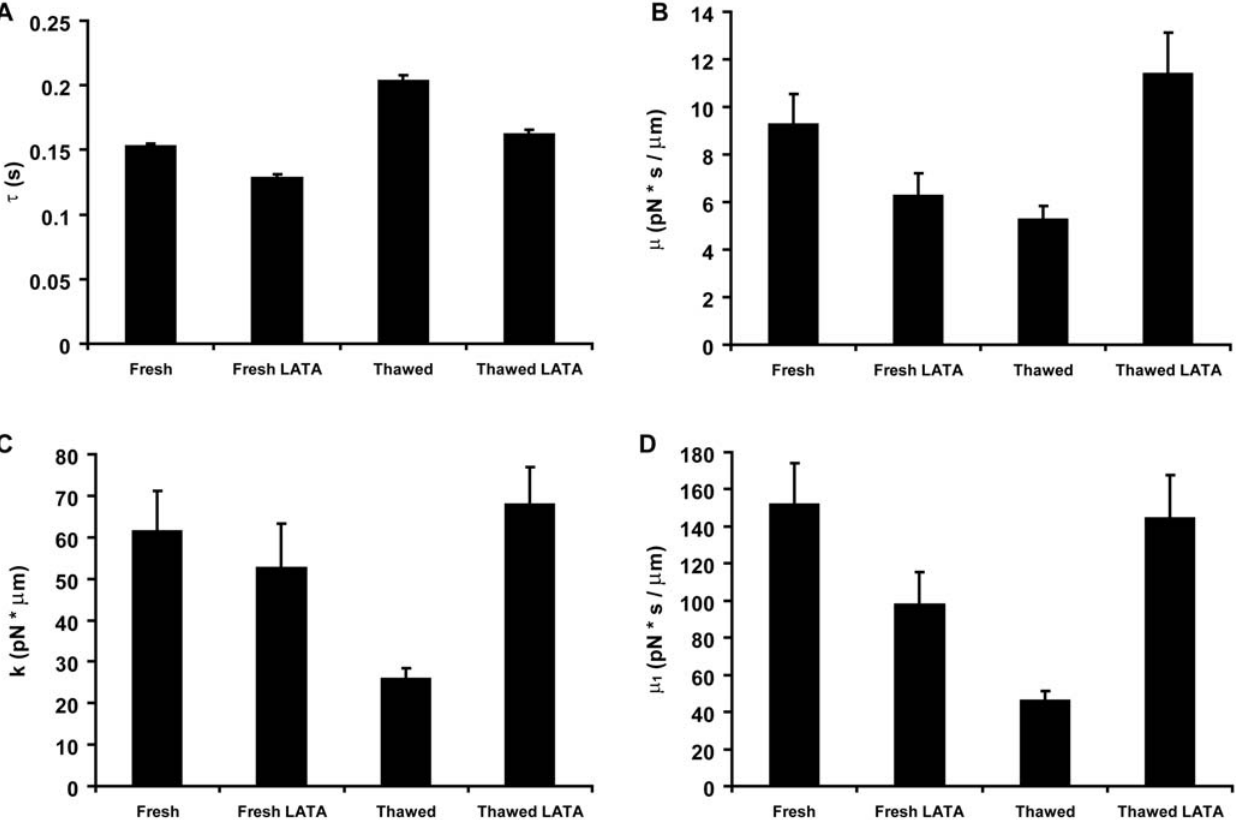
Figure 4. The oocyte viscoelastic parameters. Viscoelastic parameters before freezing without (Fresh, n = 29 cells) or with LATA treatment (Fresh-LATA, n = 28 cells) and after freezing without (Thawed, n = 16 cells) or with (Thawed LATA, n = 19 cells) LATA pretreatment. (A) Relaxation time. (B) Friction coefficient m 1 . (C) Elastic coefficient k . (D) Friction coefficient m . All viscoelastic parameters show significant statistical difference (see p values in Table 1) between the Fresh and Thawed groups and most show statistical difference between Fresh and Fresh LATA groups. There is no significant statistical difference between the Fresh and the Thawed LATA groups. Bars represent geometric mean 6 geometric SE (panel A) and mean 6 SEM (panels B, C and D).